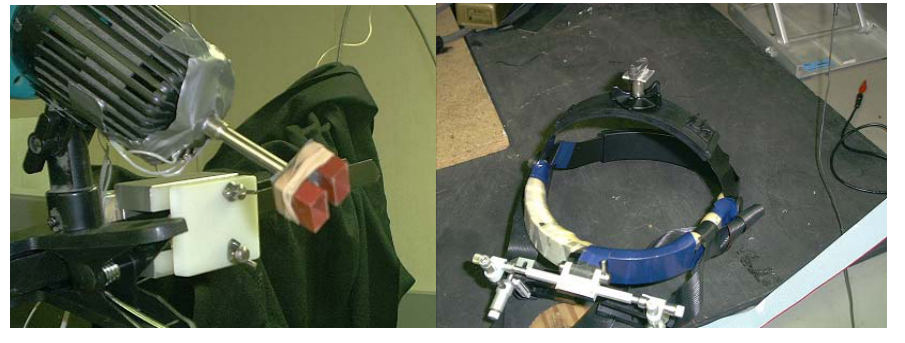
FIGURE 4 . (A) Female component of the head movement sensor consisting of a potentiometer cemented to a swivel unit (top left). A small square aluminum platform is cemented to the end of the potentiometer shaft. The rectangular magnet is cemented on top of the platform, and is flanked by two rectangular plastic members. (B) Male component of the head movement sensor, consisting of a rectangular magnet mounted on top of a threaded cylindrical unit, which in turn is screwed onto the top portion of the eye movement